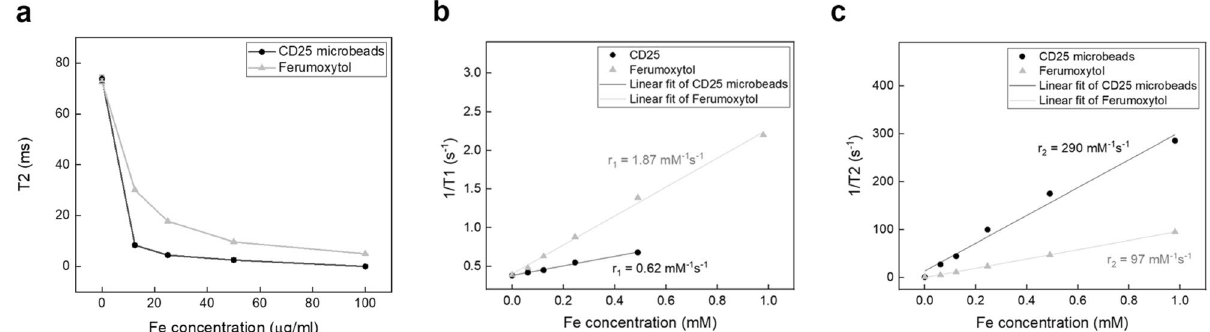
Figure 2. Quantitative T2 decay as a function of iron concentration and relaxivity measurement. ( a ) As expected, T2 values for CD25 microbeads and ferumoxytol follow an decreasing curve with increasing iron amount. T2 decay is more pronounced in CD25 microbead samples compared to ferumoxytol samples. Data are presented as ROI mean ± standard deviation. ( b ) The inverse of T1 values were plotted against iron concentration to yield CD25 microbead and ferumoxytol r 1 . ( c ) The inverse of T2 values were plotted against iron concentration to yield CD25 microbead and ferumoxytol r 2 . CD25 microbeads display much larger r 2 /r 1 ratio than ferumoxytol (r 2 /r 1 = 468 and 52